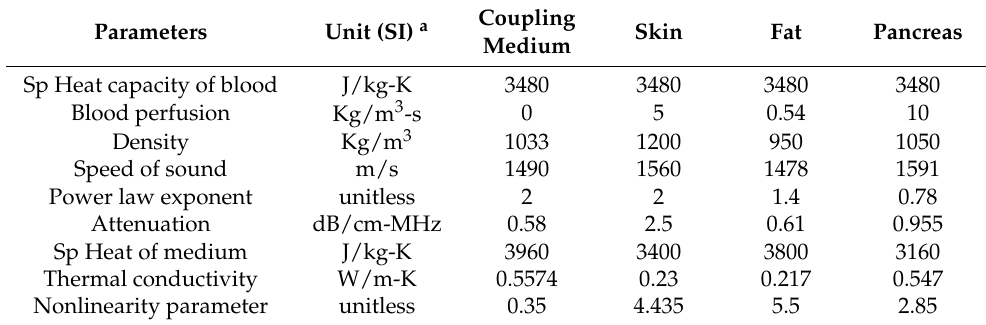
Table A3. Selected properties of tissues for focused ultrasound simulation in layered media